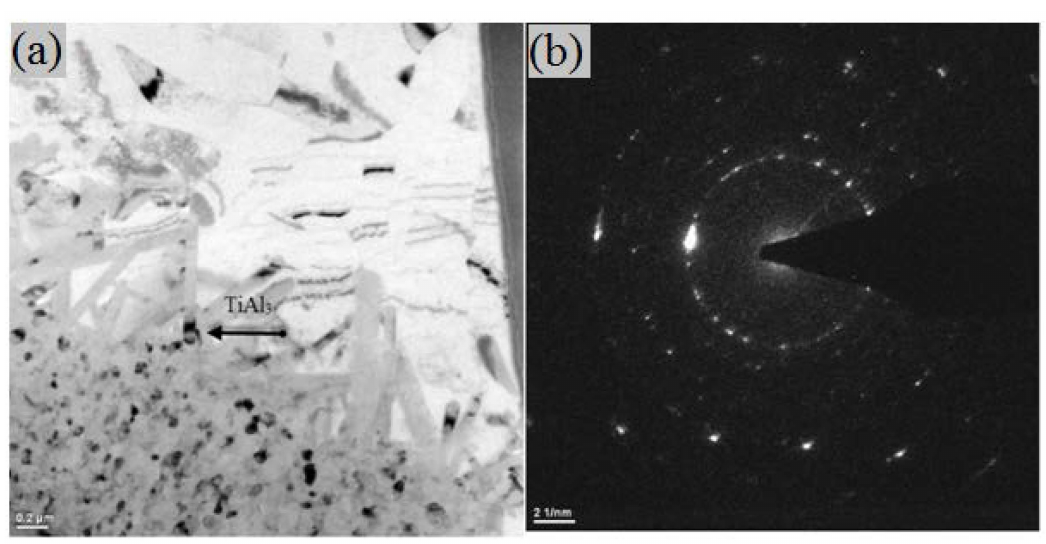
Figure 2. TEM images of 6% Ti added A356 alloy bright-area ( a ) and selected-area ( b ) diffraction pattern.